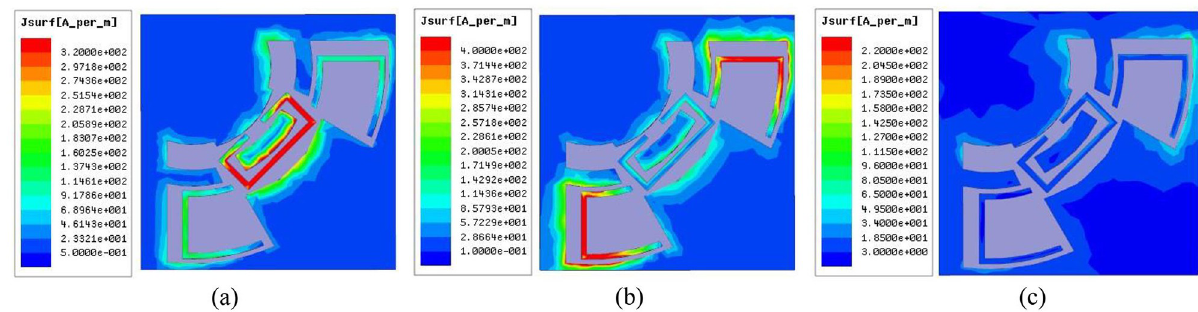
Fig 14. Surface current distribution diagram. (a) the center frequency is 9.17GHz. (b) the center frequency is 9.96GHz. (c) non-notch center frequency.